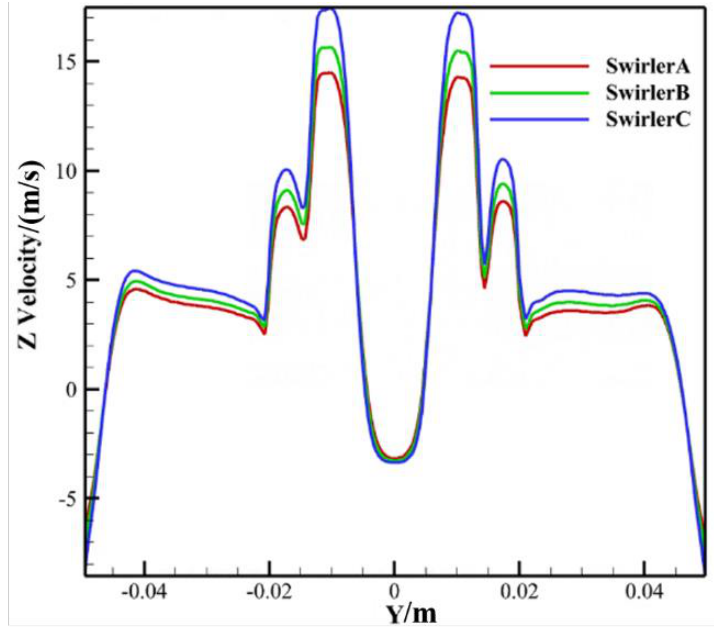
Figure 15. Average axial velocity at the outlet of swirlers.